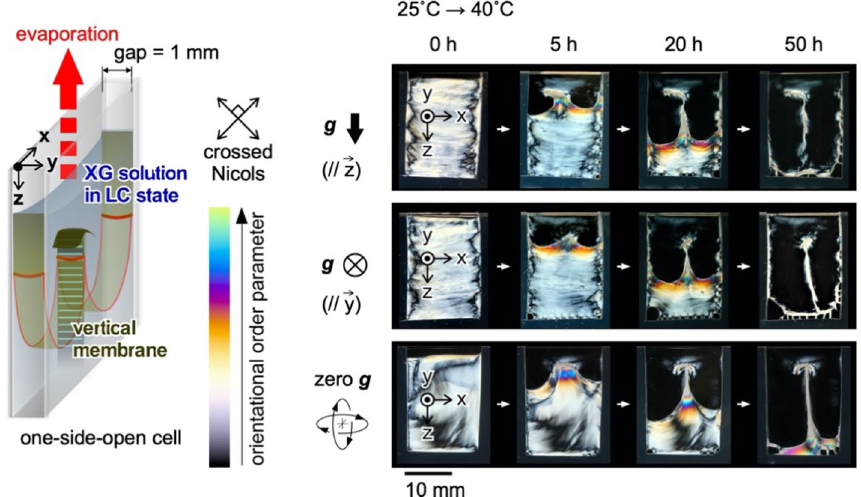
Figure 2. Effect of gravity on meniscus splitting and vertical membrane formation. Schematic of drying polymer LC solution from one-side-open cell and photographs of deposited polymer under cross-polarized light under conditions such that the gravitation force is parallel to the Z-axis, the Y-axis, and zero-gravity. Inner dimensions of the cell: (X-width, Y-thickness, Z-depth) = (15 mm, 1 mm, ~ 20 mm). Initial polymer concentration: 1.5 wt%. Drying temperature: 40